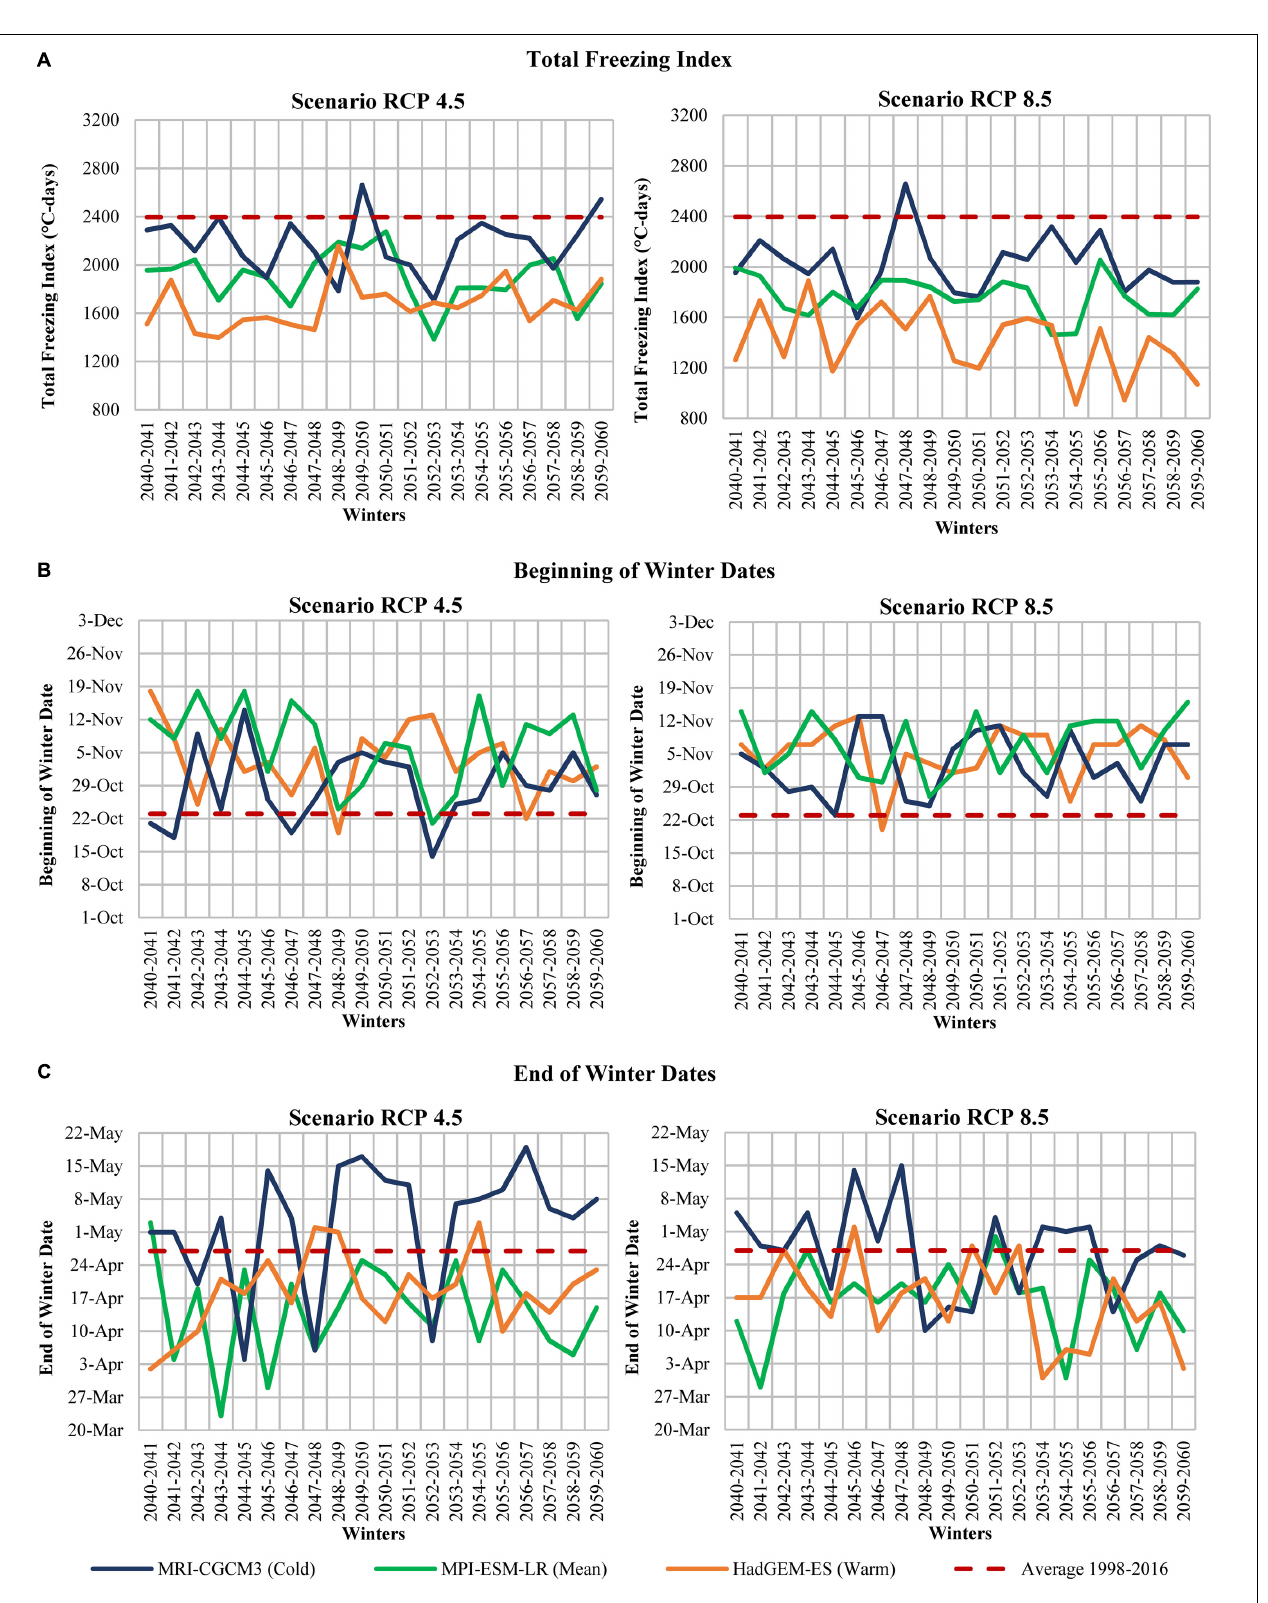
FIGURE 3 | Characteristics of projected glaciological winters at La Grande station for the 2040–2060 period under climatic scenarios RCP4.5 (left) and RCP8.5 (right). Total freezing index (A) , beginning of winter dates (B) , and end of winter dates (C) .